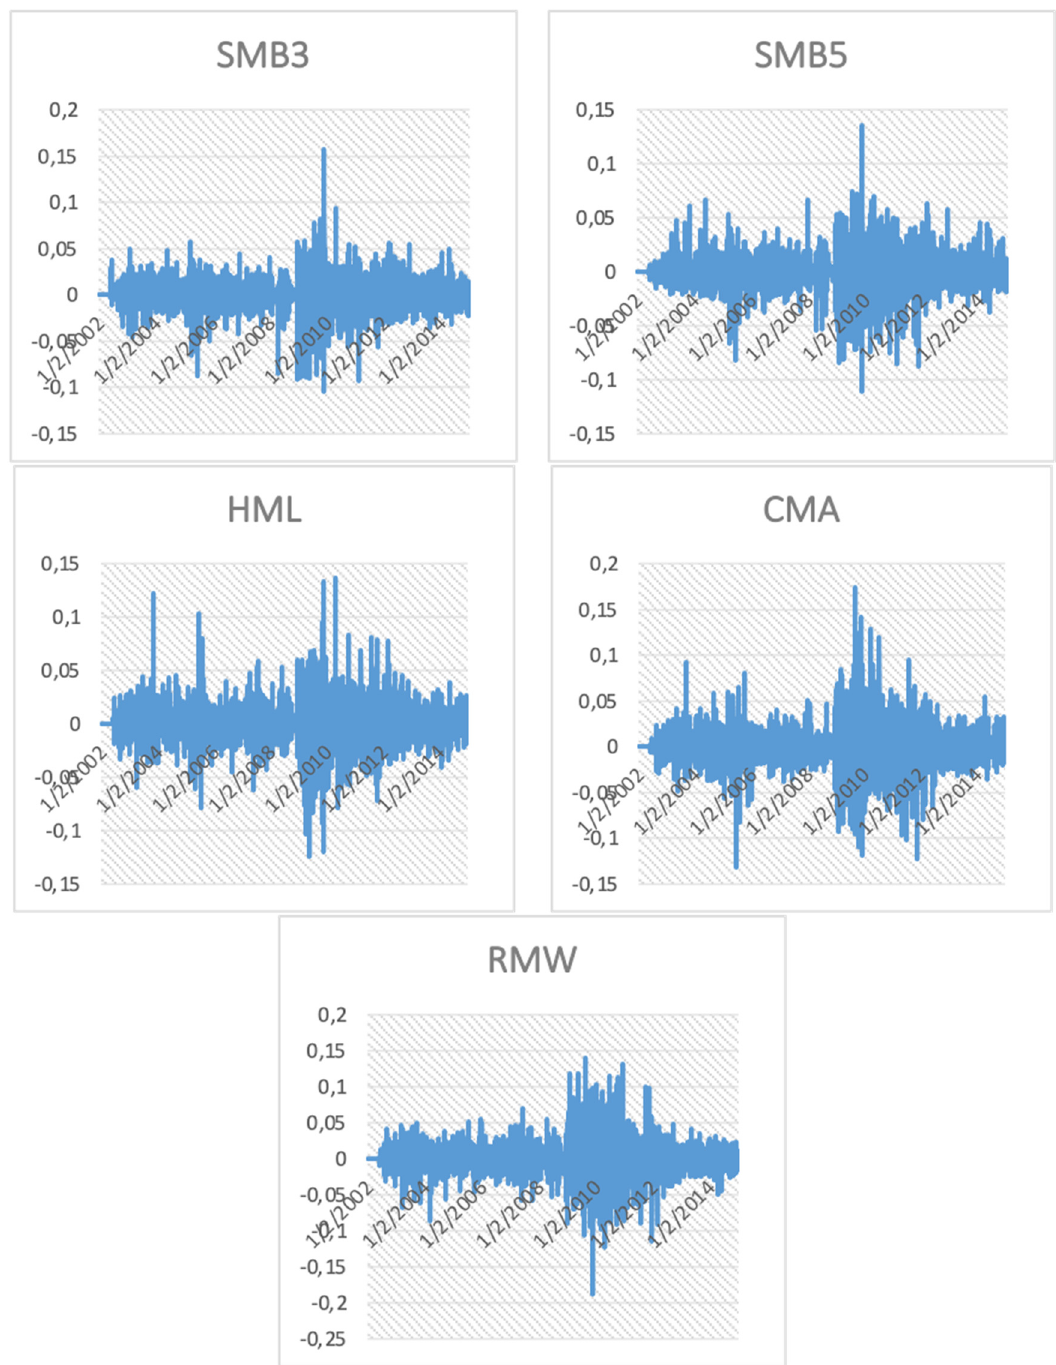
Figure A1. Time Varying Factors: Daily Data from 2002 to 2014.